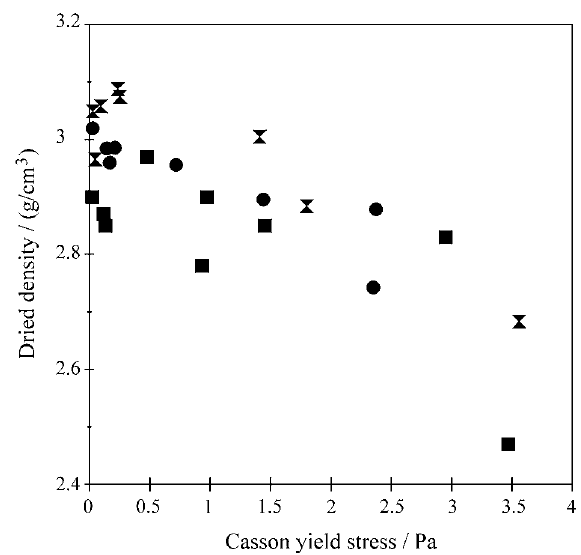
Figure 7. Relative density of green compacts prepared from 48 vol% suspensions of: • stoichiometric, with a 6 wt% excess of alumina and x with a 10 wt% excess of zircon powder mixtures by pressure